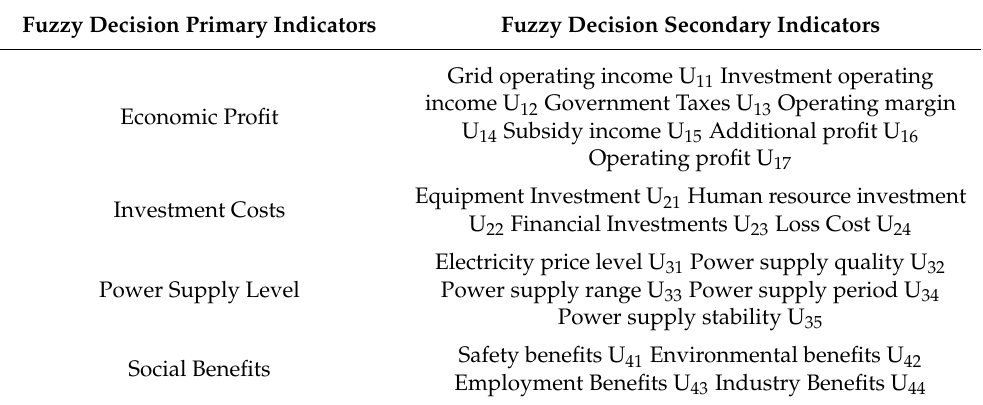
Table 1. Fuzzy decision indicator system for photovoltaic power generation business model.